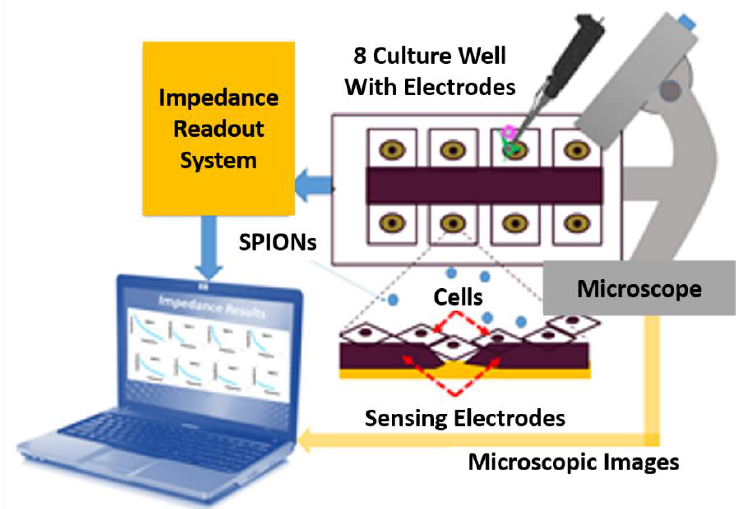
Figure 2. Scheme of proposed experimental setup including an array of 8 sensors incorporated with cell culture wells. These electrodes are connected to a computer through an impedance readout system. The cells are loaded by a standard pipette and observed under a microscope.